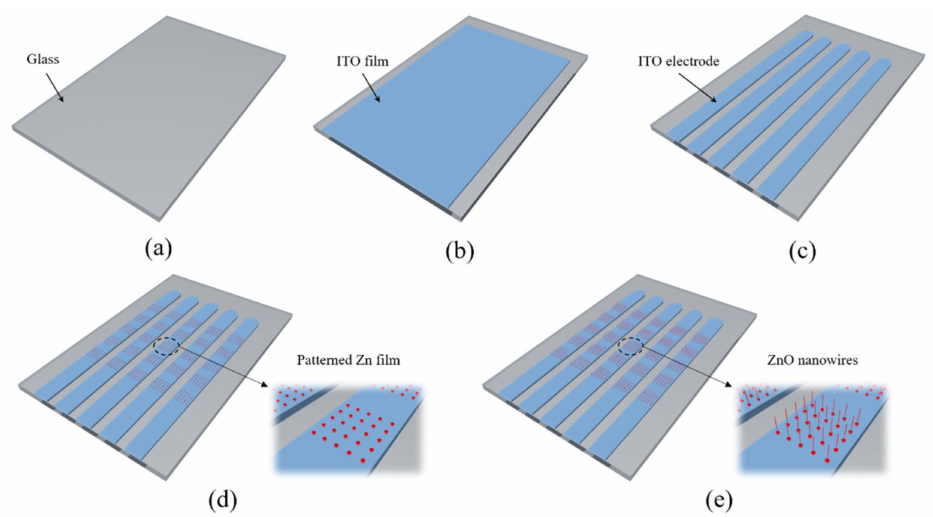
Figure 2. Preparation process of the cathode panel. ( a ) Cleaning of a glass substrate; ( b ) ITO film deposition; ( c ) etching of the ITO film to form electrode; ( d ) formation of Zn patterns; ( e ) growth of ZnO nanowires by the thermal oxidation